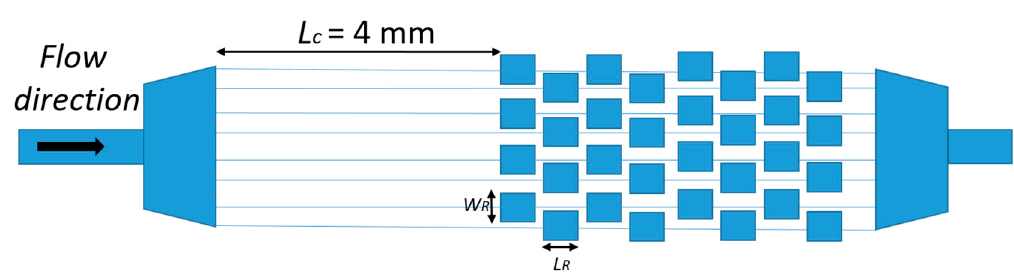
Figure 5. Vortex chip design of Sollier et al. [83]. The chip consists of eight channels (40 um wide, 80–85 um high) in parallel, with eight reservoirs ( W R = 480 um, L R = 720 um) for each of them. The input channels of length L C allow the focus of the randomly injected particles. Adapted from [85].